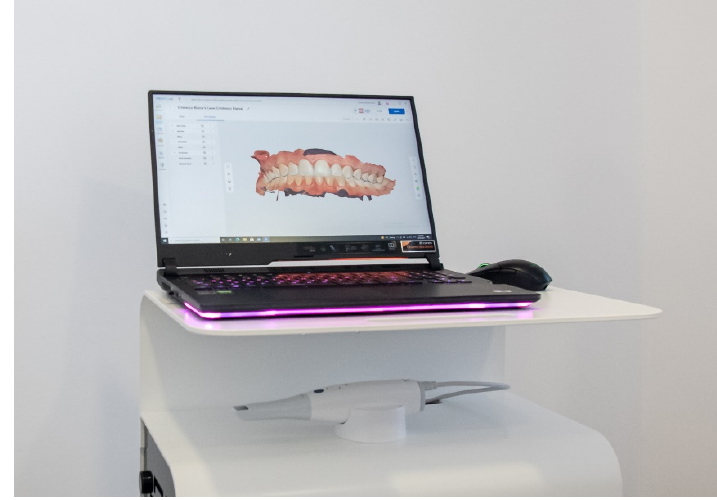
Figure 2. Intraoral scanner MEDIT i700 (Family Dental Clinic).